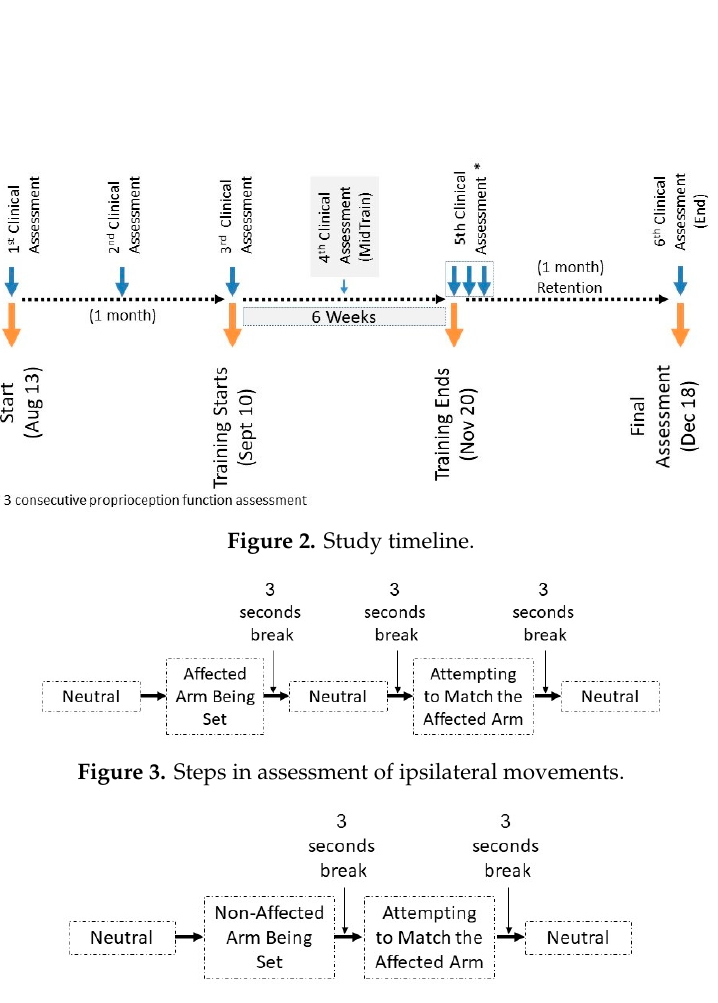
Figure 4. Contralateral movements assessment steps.